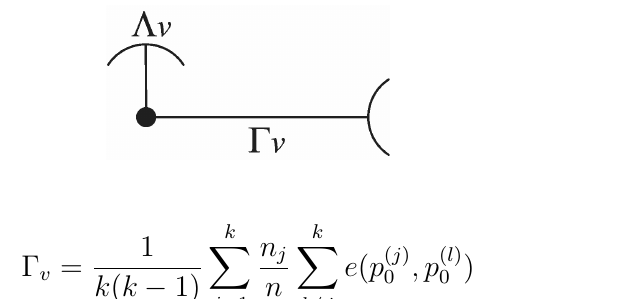
Figure 1. Symbol for a representative clustered-vector. The short segment with the concave arc stands for the average intra-cluster distance, the long segment with the convex arc for the average inter-cluster